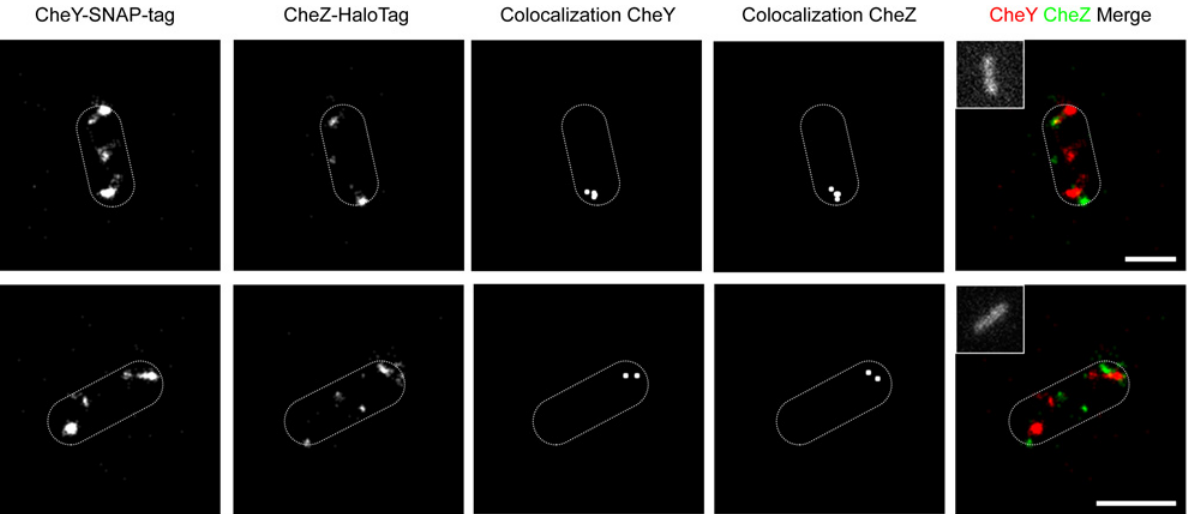
Fig 7. Subcellular localization of chemotaxis proteins CheY and CheZ. Two representative S . Typhimurium cells co-expressing fusions of CheY and CheZ to Halo- and SNAP-Tag from Expression clone pWRG602 are shown. Fusion proteins were labeled with Atto655-coupled HaloTag ligand and the SNAP-tag ligand TMR-Star. Subcellular localization of protein clusters was visualized using super-resolution microscopy (dSTORM). Colocalization of the labeled fusion proteins was calculated in separate images using the Matlab-based software Slimfast with a distance threshold of 100 nm. The insets show autofluorescence of the bacteria after excitation at 488 nm which was used to determine their shapes (dashed white lines). Scale bars = 1 μ m.